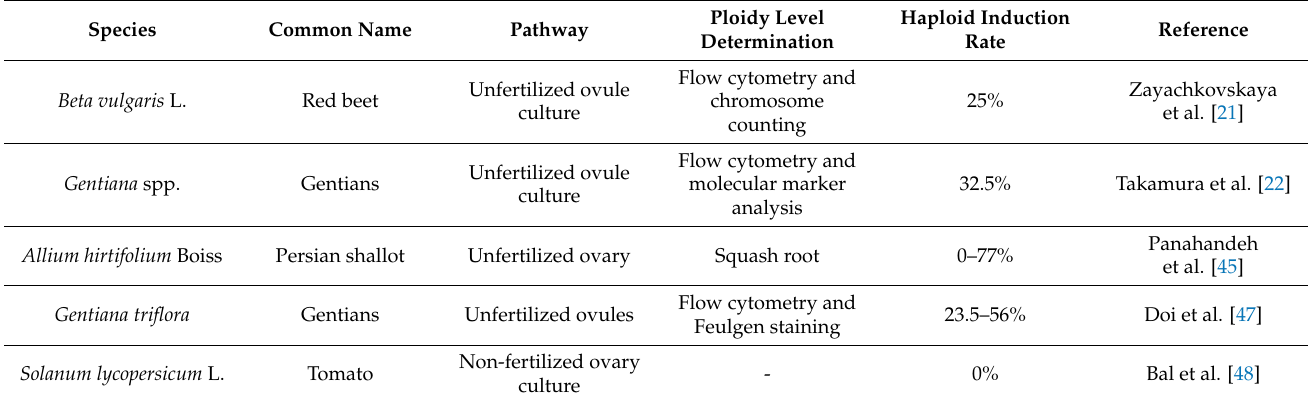
Table 2. Examples of protocols used for successful haploid induction mediated in vitro culture of unfertilized ovaries or